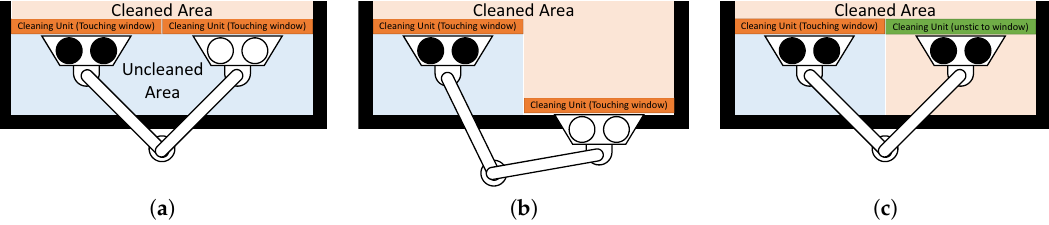
Figure 7. Movement sequence of the biped-type robot. Orange coloured rectangles represent the cleaning unit in contact with glass surface and green coloured rectangles represents cleaning unit away from the surface. ( a ) Vacuum inside the suction cups on the right leg is released; ( b ) the cleaning unit moves towards the bottom edge of the window frame; ( c ) the cleaning unit returns to the initial position and the vacuum inside suction cups are re-established. The same procedure is repeated on the right leg and cleaning is accomplished.